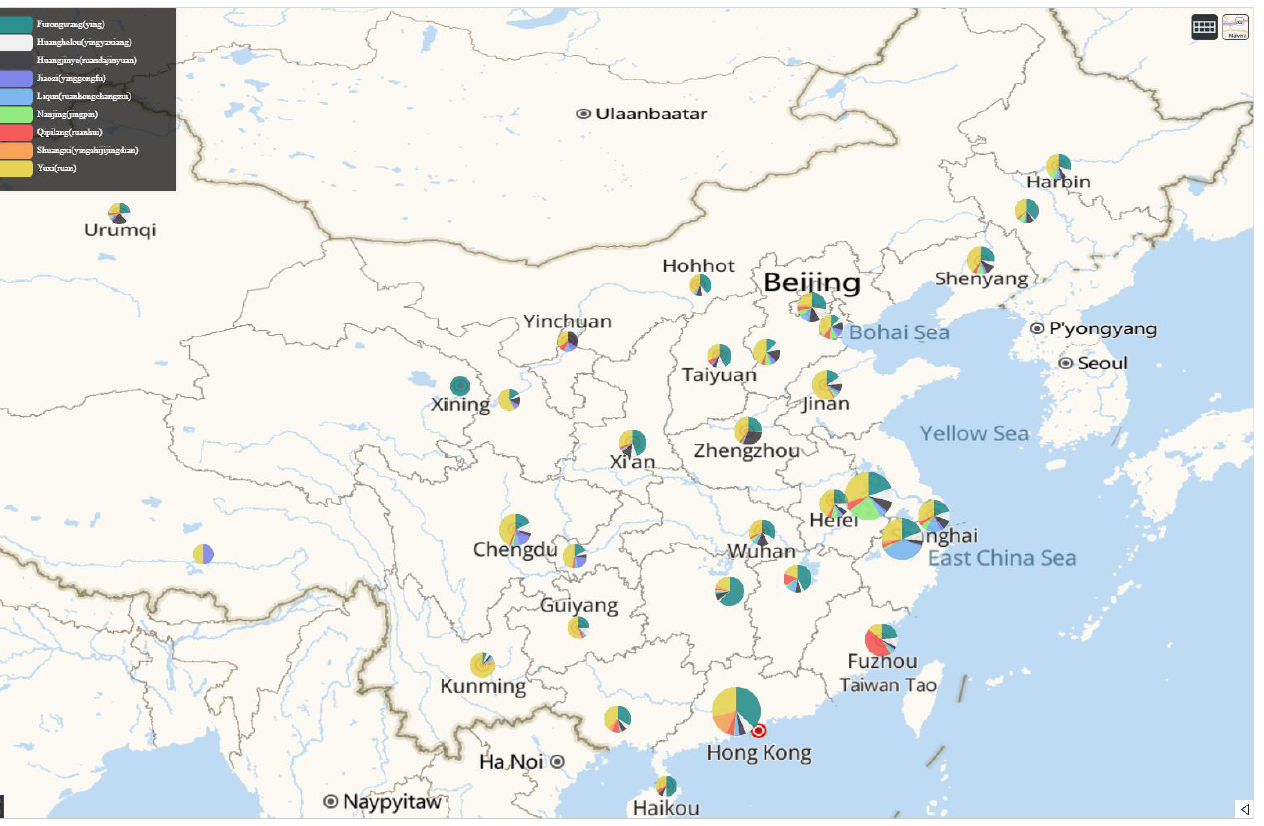
Figure 8. Spatial distribution of industrial usability of flue-cured tobacco